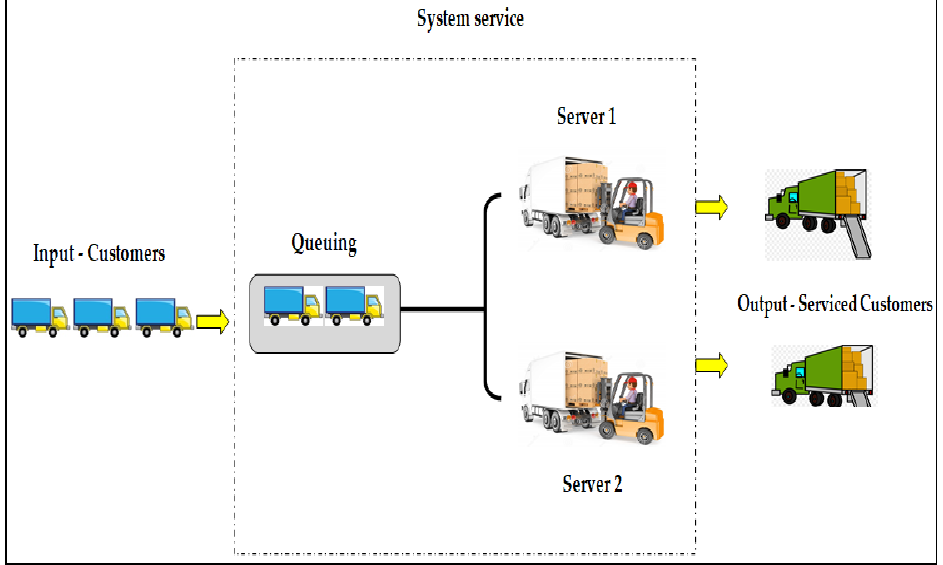
Figure 3. The basic process of the queuing system for the PM4 warehouse4.1. Data